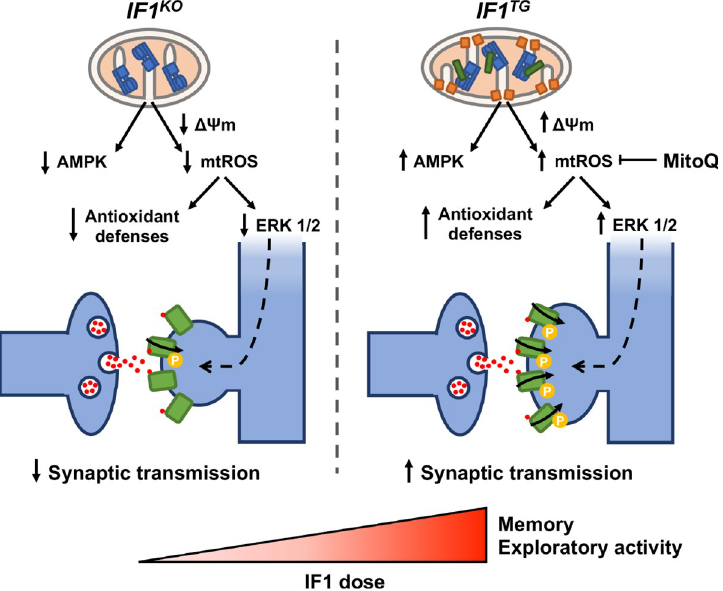
Fig 8. IF1 promotes synaptic function and cognition in mice. IF1 KO in forebrain neurons affects mitochondrial structure and function and impairs memory. IF1 overexpression partially arrests OXPHOS, promotes the activation of AMPK and mtROS/ERK 1/2, and increase synaptic transmission and memory. Δ C m, mitochondrial membrane potential; AMPK, AMP-activated protein kinase; ERK 1/2, extracellular signal-regulated kinase 1/2; IF1, ATPase inhibitory factor 1; IF1 KO , IF1 knockout; IF1 TG , IF1 overexpressing transgenic; mtROS, mitochondrial reactive oxygen species; OXPHOS, oxidative phosphorylation.